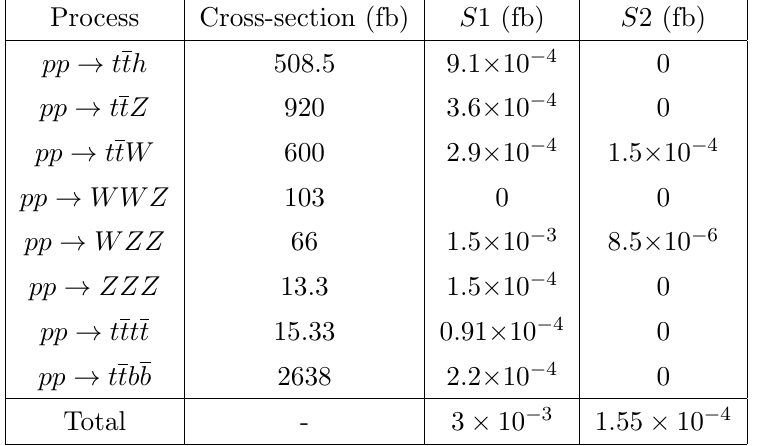
Table 7 . Background cross-sections in the 3SSL channel after passing the selection criteria S 1 (third column) and S 2 (fourth column) at the 13 TeV